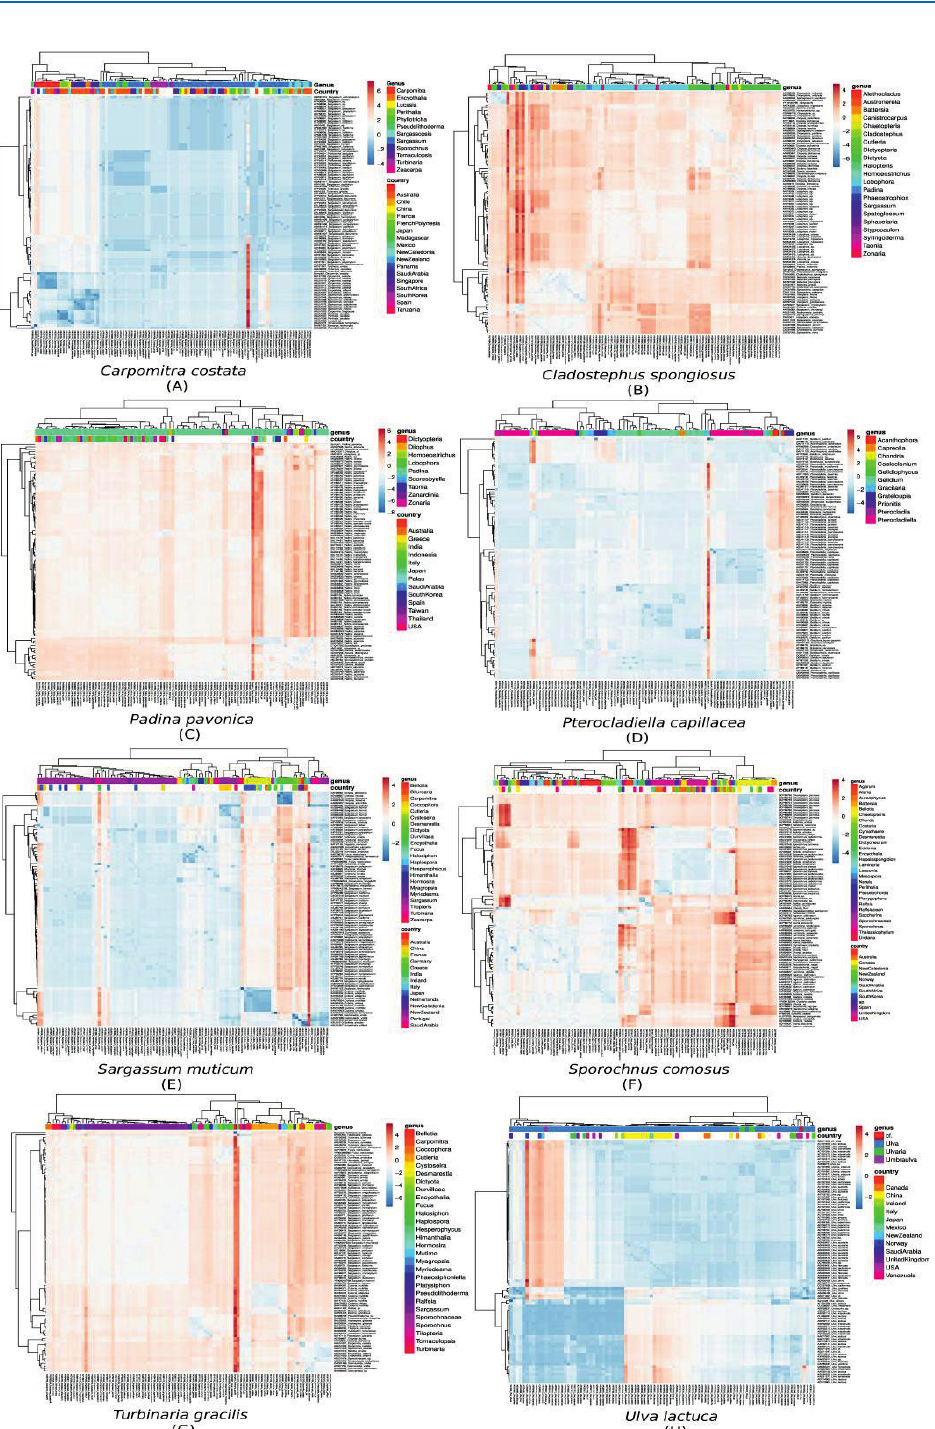
Fig. 3 . The multiple sequence alignment matrices showing the relation between different seaweads specimens according to country and genus. The similarity scale ranged from highly similar sequences (blue) to highly divergence sequences